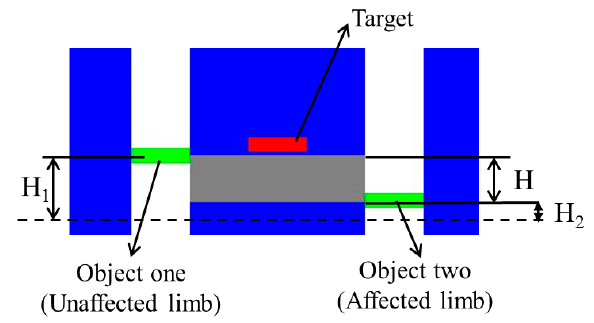
Figure 6. Proposed training model.